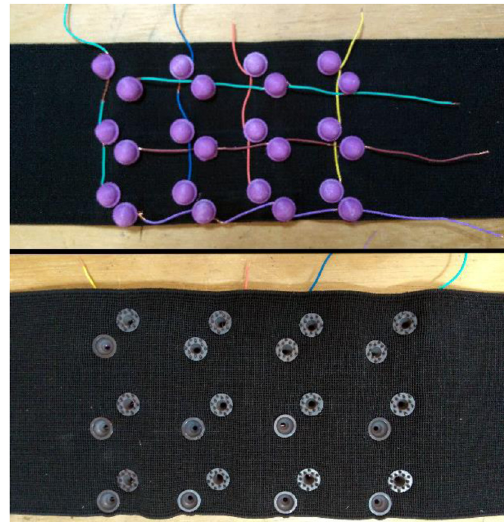
Figure 8: The top side of the electrodes with the 3D printed caps ( purple ) connected as lines and columns and the bottom side which is in contact with the